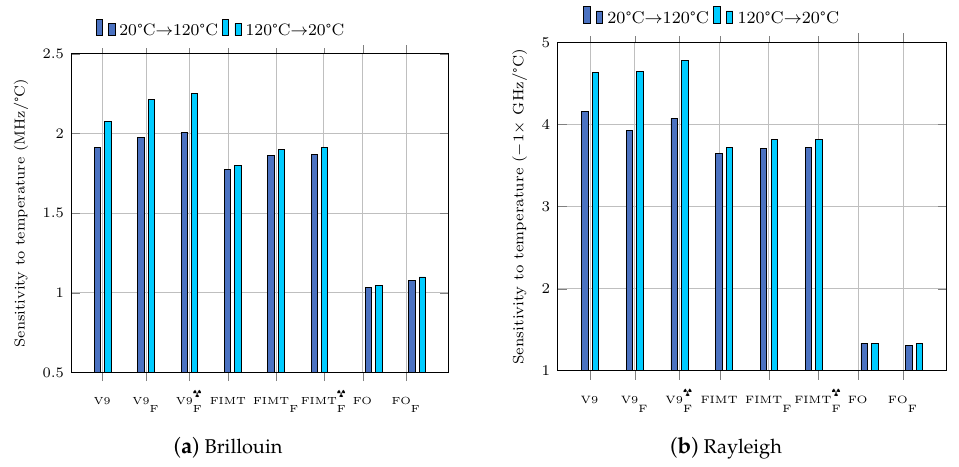
Figure 2. Sensitivity to temperature of different cables